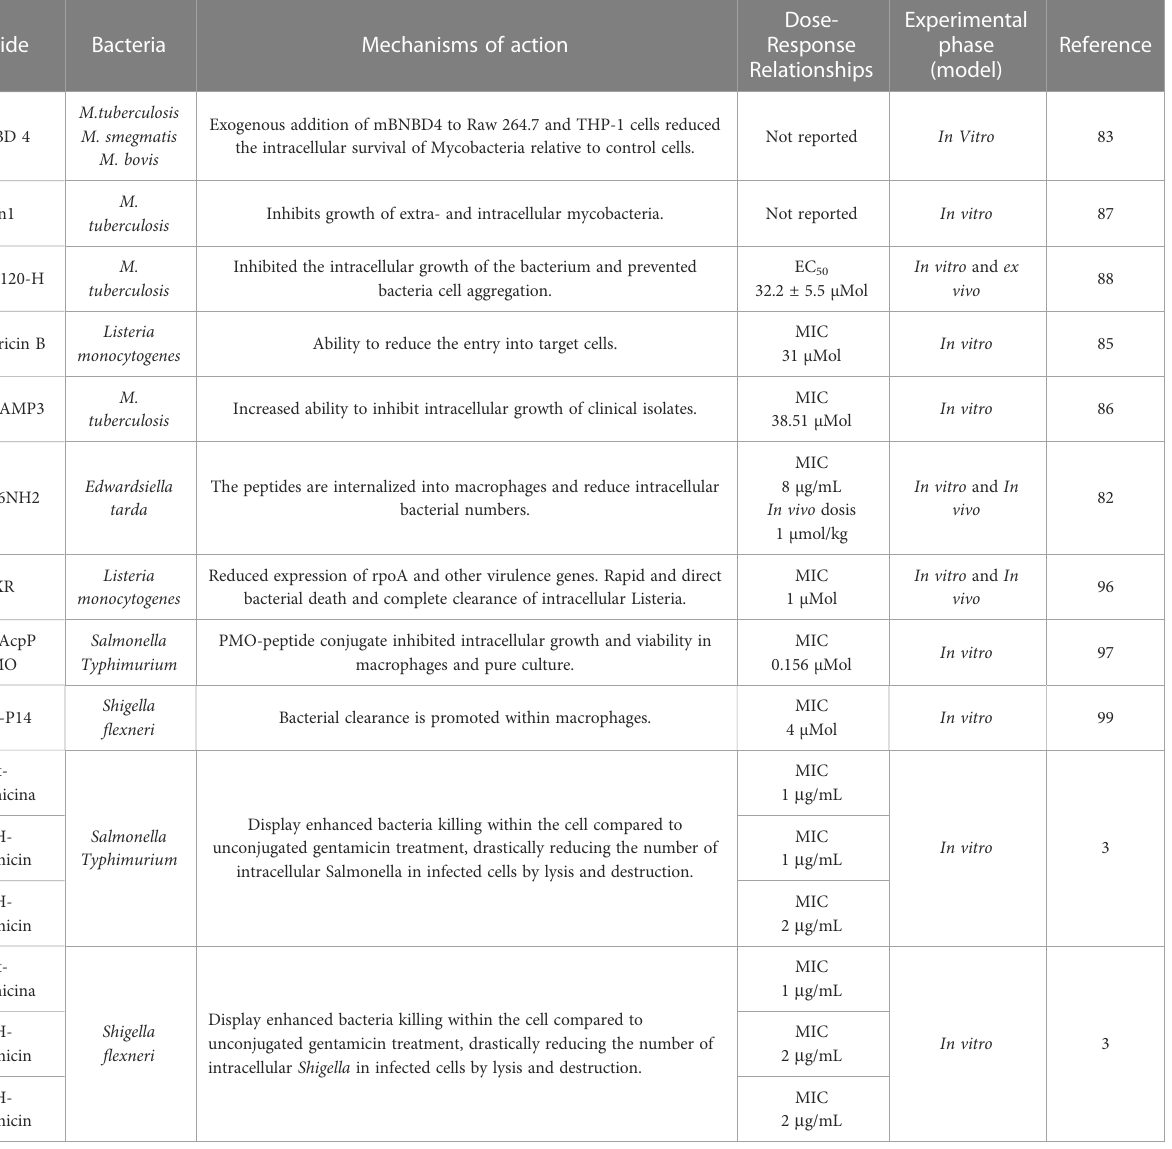
TABLE 2 Antimicrobial activity of AMPs against intracellular bacteria within the cell.